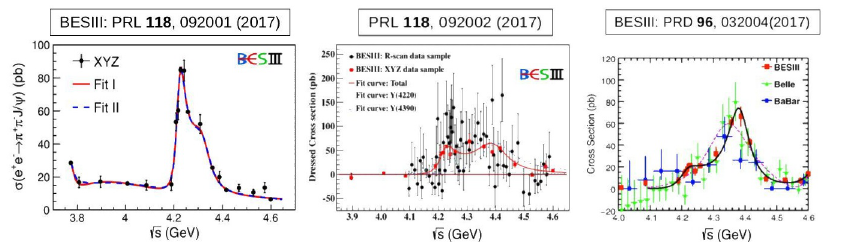
Figure 3. Cross section of the the Y process of interest: π + π − J /ψ on the left, π + π − h C in the middle and π + π − ψ (3686) on the